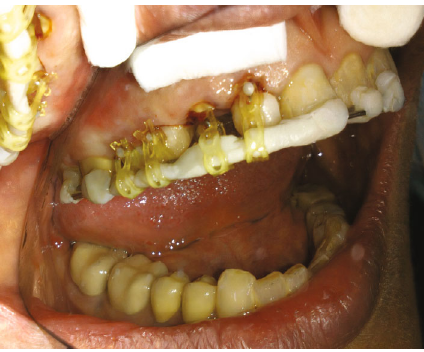
Figure 6: Buccal view of fi xed appliance used for orthodontic extrusion of four teeth.